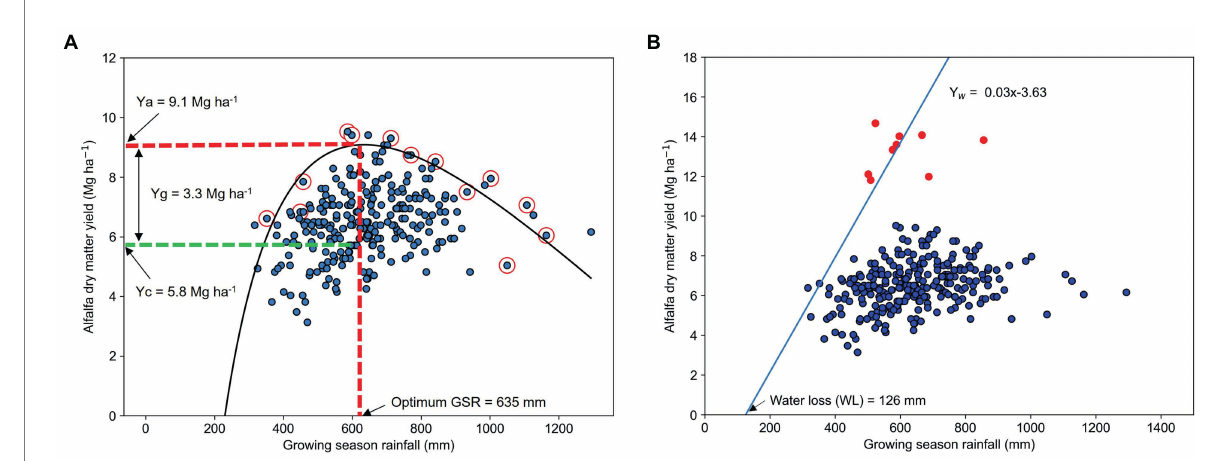
FIGURE 3 Example of estimating (A) attainable yield (Ya) using frontier yield function and (B) water-limited potential yield (Yw) using linear boundary function, in this example for the state of Wisconsin (WI). The value in the peak of the nonlinear line in panel A represents maximum attainable yield (the red dotted line intersecting Y -axis) at an optimum growing season rainfall of 635 mm (the red dotted line intersecting in X -axis). The slope of a linear line in panel B represents the water-limited potential yield (Yw) obtained from growing season rainfall, after allowing for a minimum loss of 126 mm during the entire growing season. The blue dotted markers represent annual yield for a 10 year period (2009–2018) of selected counties within WI ( n = 29) obtained from USDA-NASS. The red circled dotted markers in panel A represent maximum yield achieved in a county within a certain rainfall range and the red dotted points in panel B represent data from variety trials conducted at Outagamie County of WI during the study